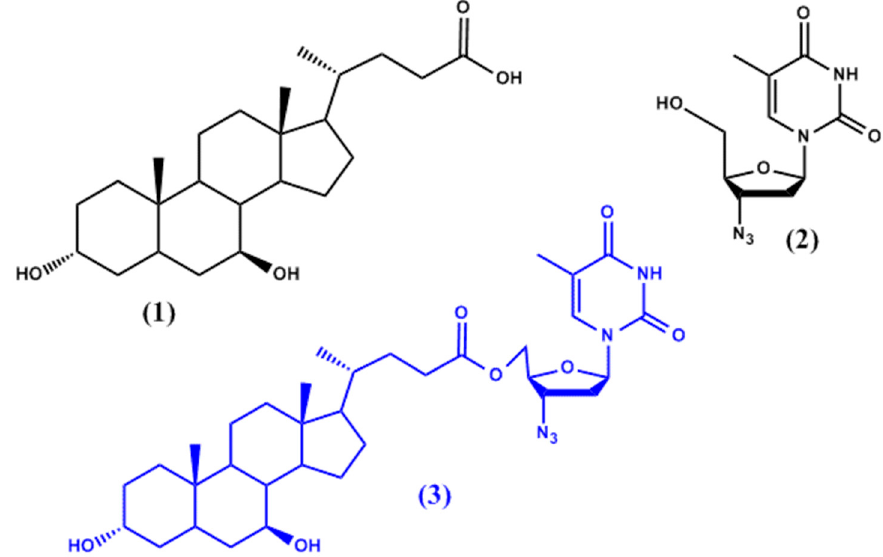
Figure 1. Chemical structures of ursodeoxycholic acid (UDCA) ( 1 ), azidothymidine (AZT) ( 2 ), and the prodrug (AZT-UDCA) ( 3 ).